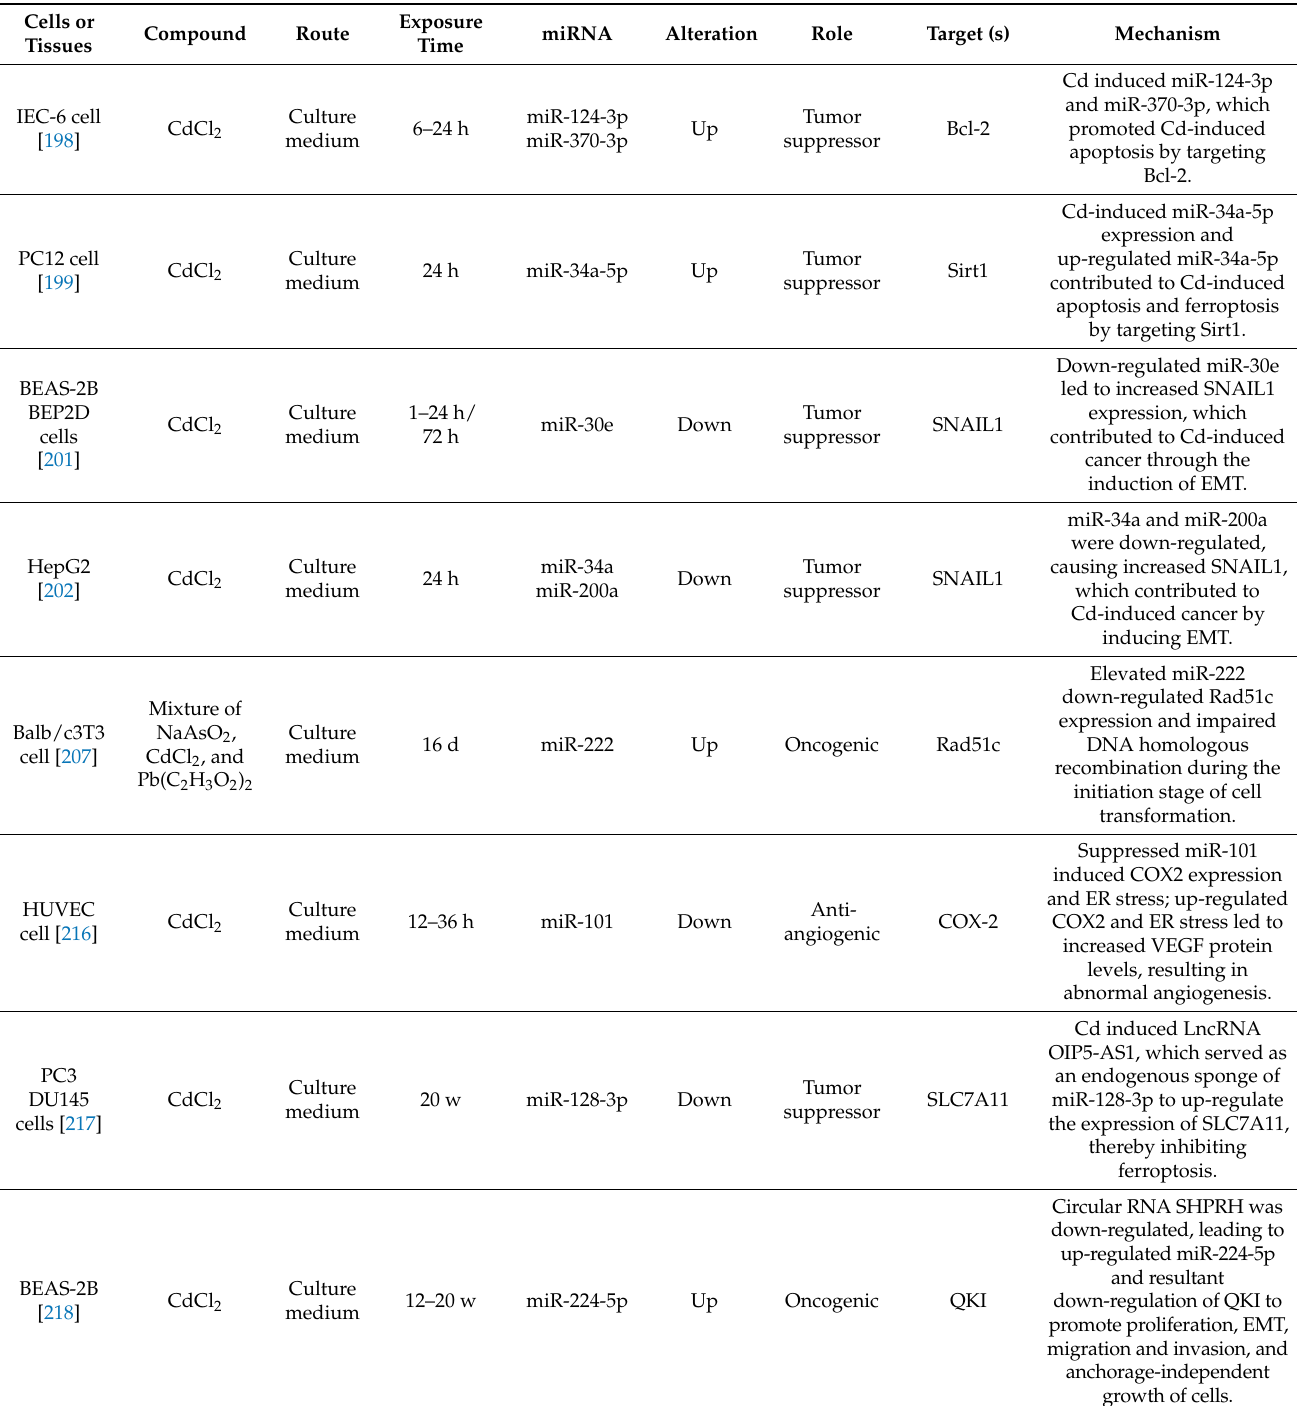
Table 9. Roles of altered miRNA in Cd-induced